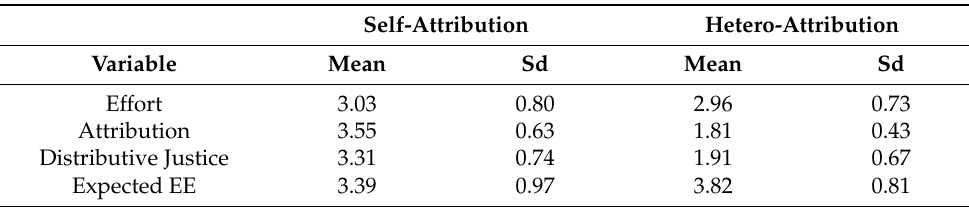
Table 1. Means and standard deviations for the study variables in each condition.